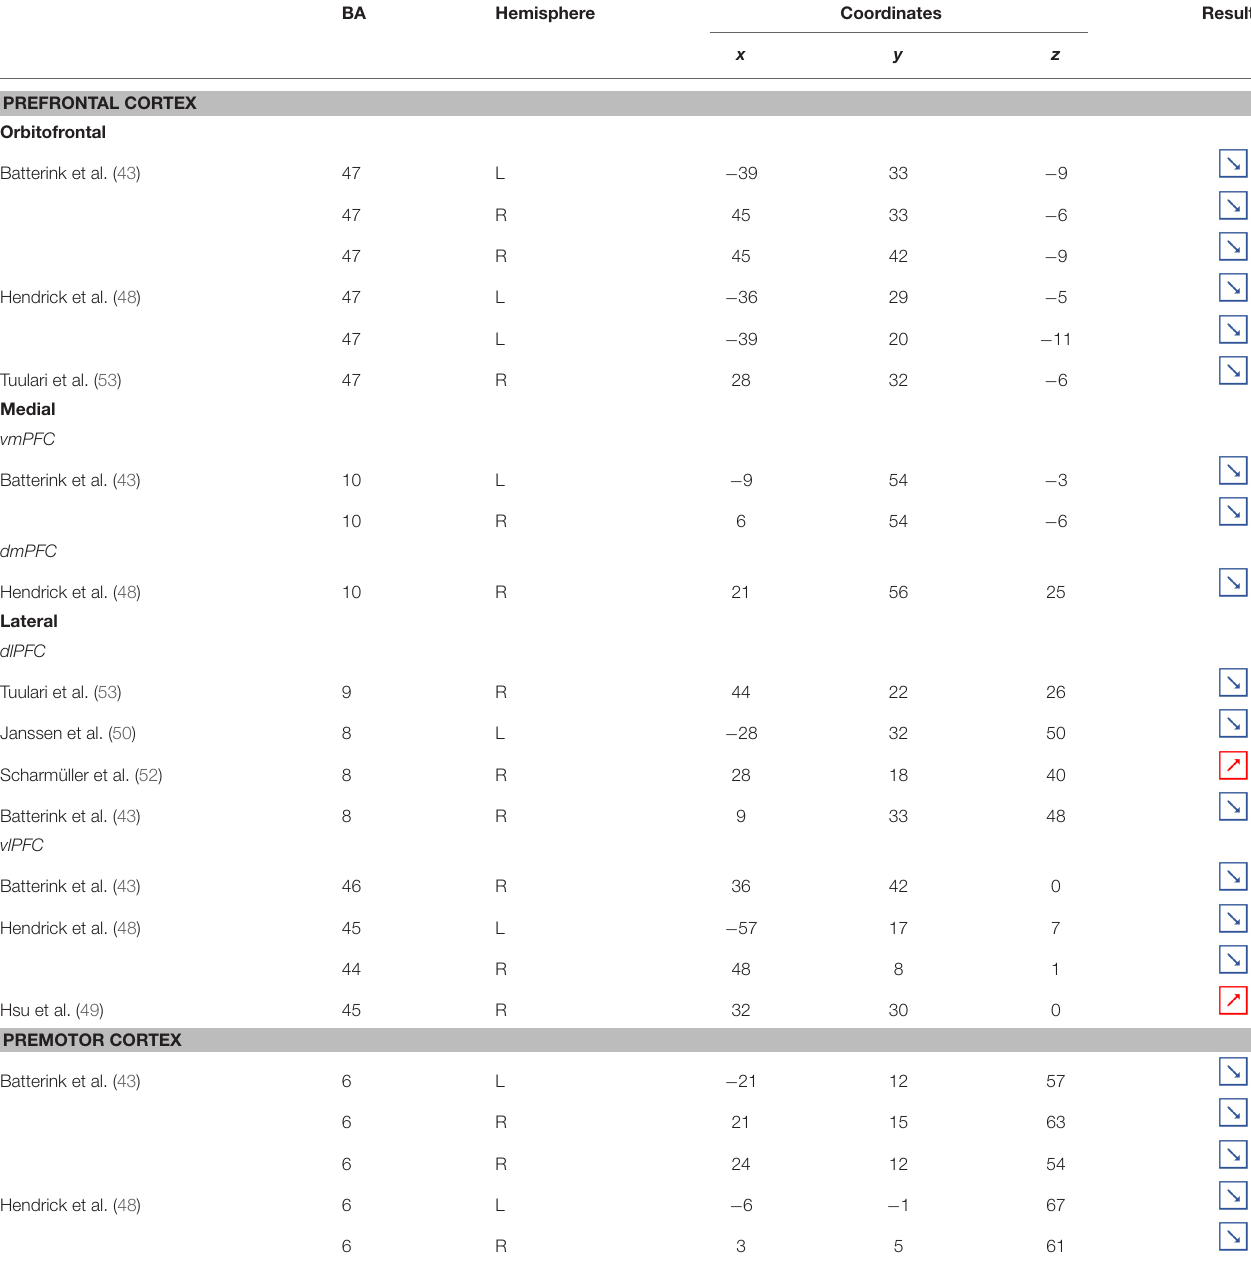
TABLE 2 | Neural activity in frontal regions during inhibition in obese in comparison with lean individuals. BA Hemisphere Coordinates Results x y